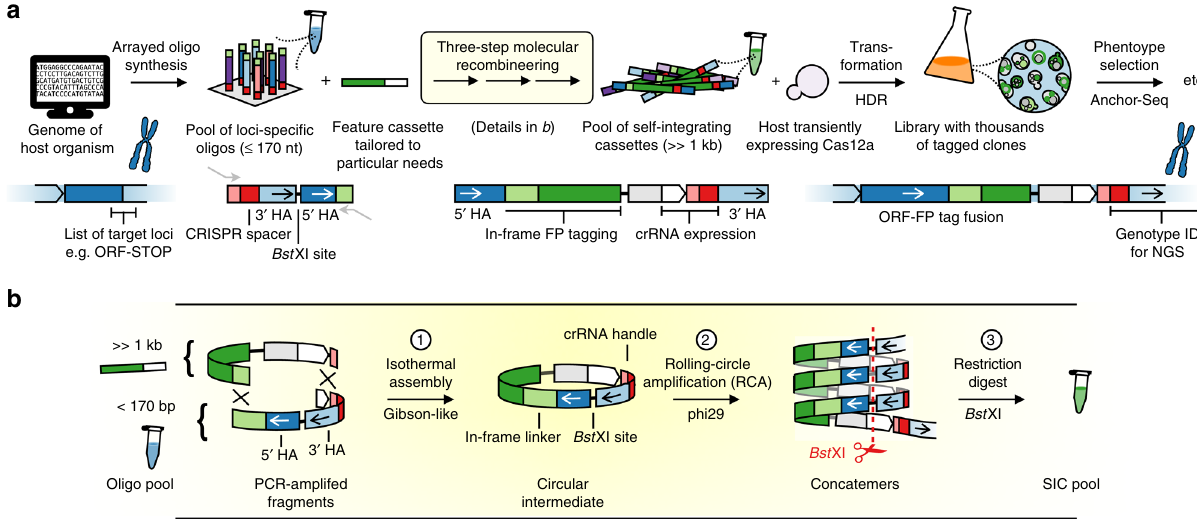
Fig. 2 CRISPR-Cas12a (Cpf1)-assisted tag library engineering (CASTLING) in a nutshell. a For each target locus, a DNA oligonucleotide with site-speci fi c homology arms (HAs) and a CRISPR spacer encoding a target-speci fi c CRISPR RNAs (crRNA) is designed and synthesized as part of an oligonucleotide array. The resulting oligonucleotide pool is recombineered with a custom-tailored feature cassette into a pool of self-integrating cassettes (SICs). This results in a clone collection (library) that can be subjected to phenotypic screening and genotyping, for example, using Anchor-Seq 12 . b The three-step recombineering procedure for SIC pool generation; details are given in the main text and